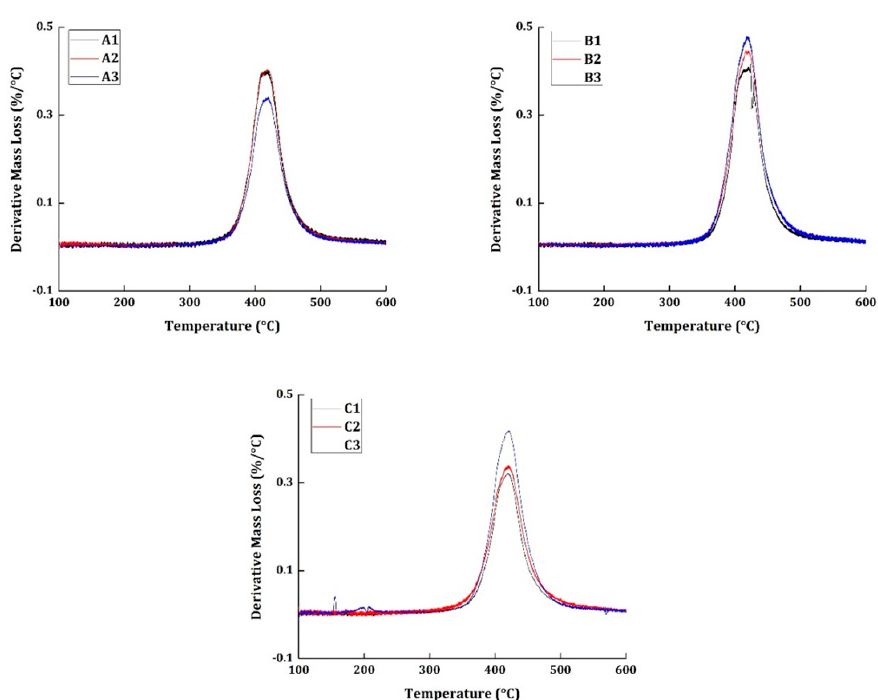
Figure 3. Derivative mass loss results of all the specimens tested at 20 °C/min heating rate